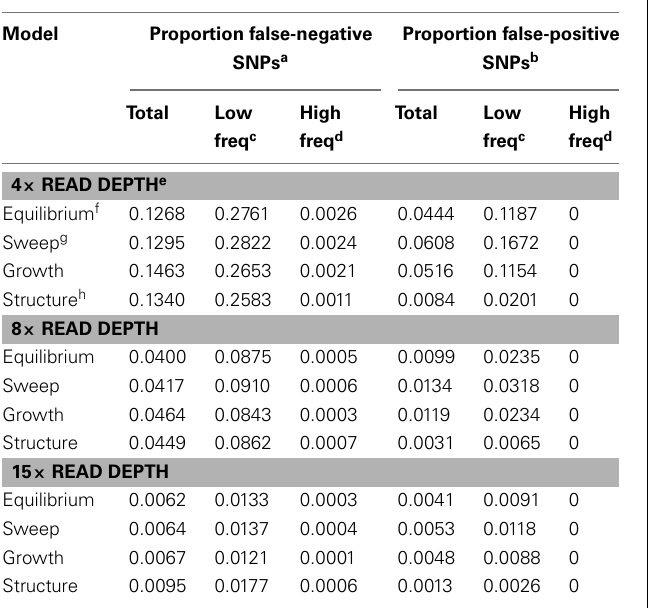
Table 1 | Effect of readdepth and population genetic model on false negative and false-positive SNP rates.